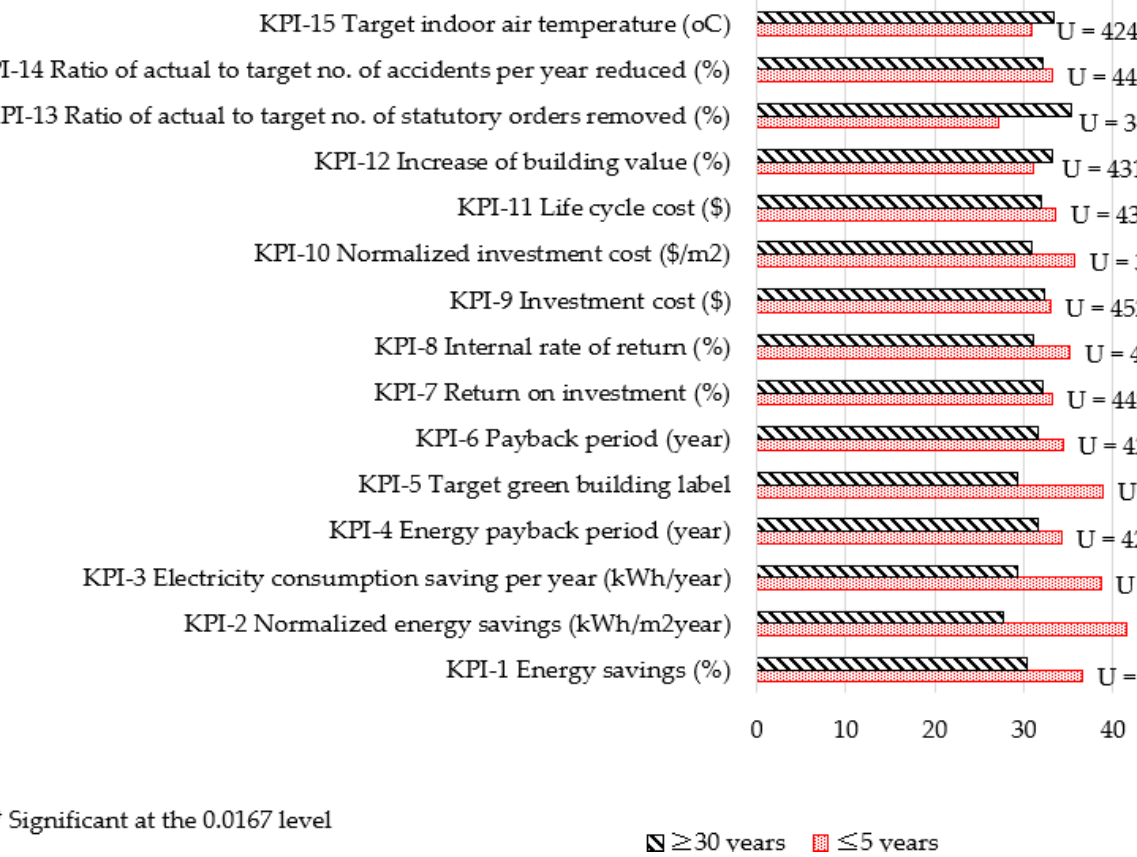
Figure A7. Mann – Whitney U-test results of G2 (work experience: G2a vs. G2d). Figure A7. Mann–Whitney U-test results of G2 (work experience: G2a vs.